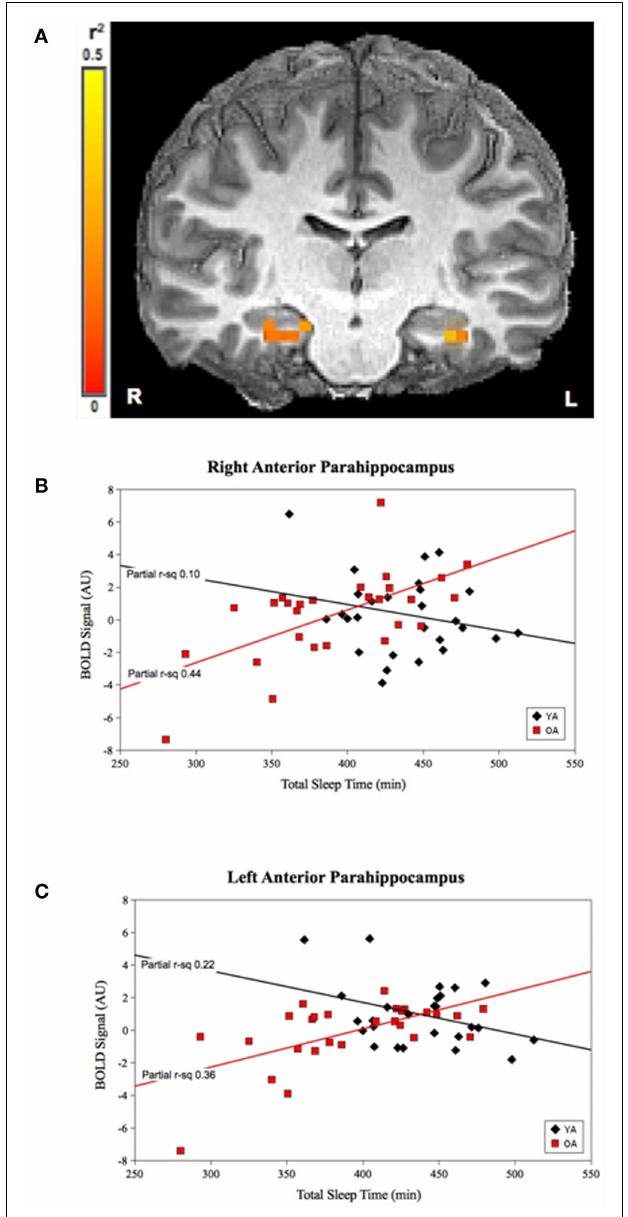
FIGURE 1 | Group-by-prior sleep interaction forTST. Bilateral anterior parahippocampal regions showing a group-by-TST interaction. (A) Color scale represents r 2 associated with the interaction term in the statistical model (max r 2 = 0.5). (B,C) Graphs show a strong, positiveTST–BOLD correlation in OLD (both regions p < 0.001), with no significant correlation for theYOUNG ( p > 0.05) in the right APH and a significant negative correlation for theYOUNG in the left APH ( p < 0.05). (Effect sizes are partial r 2 for OLD andYOUNG separately, accounting for effects of performance and the main effects of group